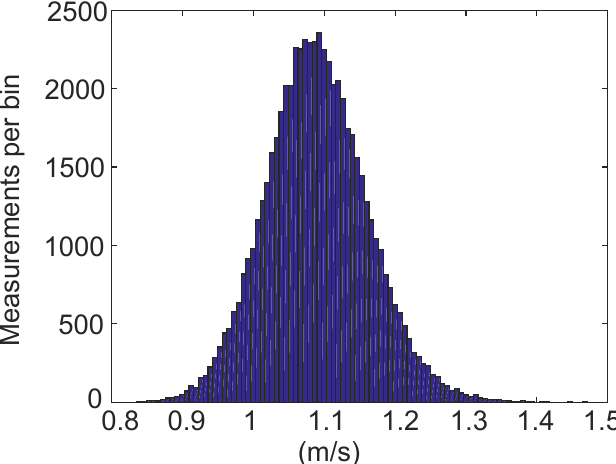
Figure 7. Histogram of the fraction of the upstream and the downstream measurements during one